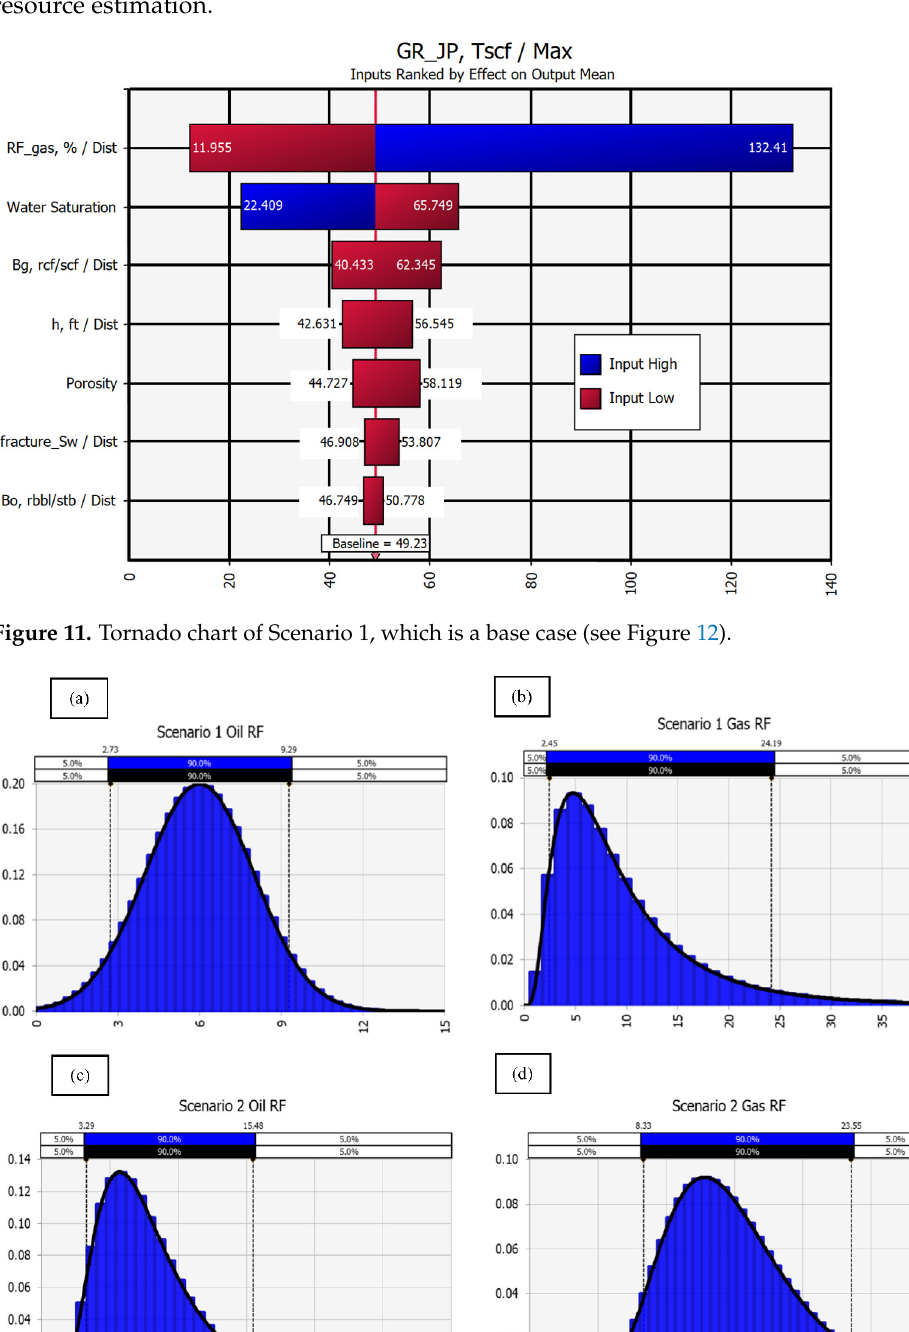
Table 7. Summary of distribution inputs of recovery factors.